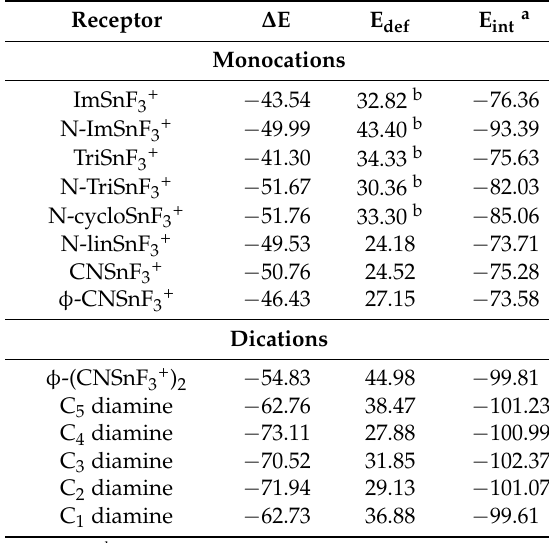
Table 8. Binding, deformation, and interaction energy (kcal/mol) for interactions between Cl − and indicated receptors. Receptor ∆ E E def E int a Monocations ImSnF 3+ − 43.54 32.82